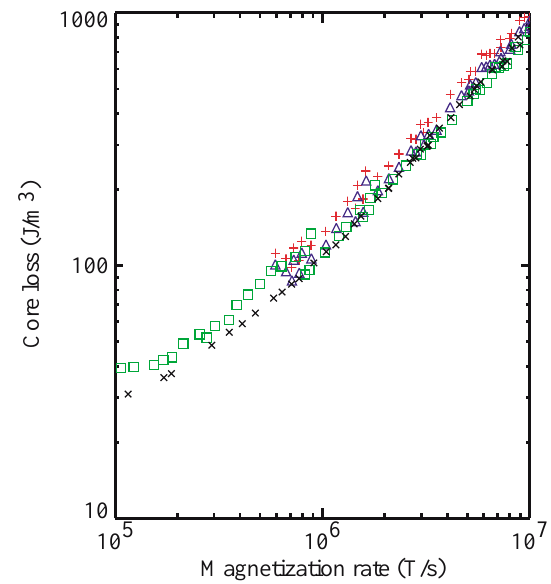
FIG. 20. (Color) Core loss versus magnetization rate for three Vitroperm nanocrystalline cores, manufactured by NAM, core-1 listed at two flux swings. The data are for the listed flux swings: ( (cid:1) , green) NAM-nano-2 at 2.15 T; ( (cid:3) , blue) NAM-nano-1 at 2.15 T; ( 1 , red) NAM-nano-1 at 2.25 T; and ( 3 , black) NAM- nano-3 at 2.10 T.